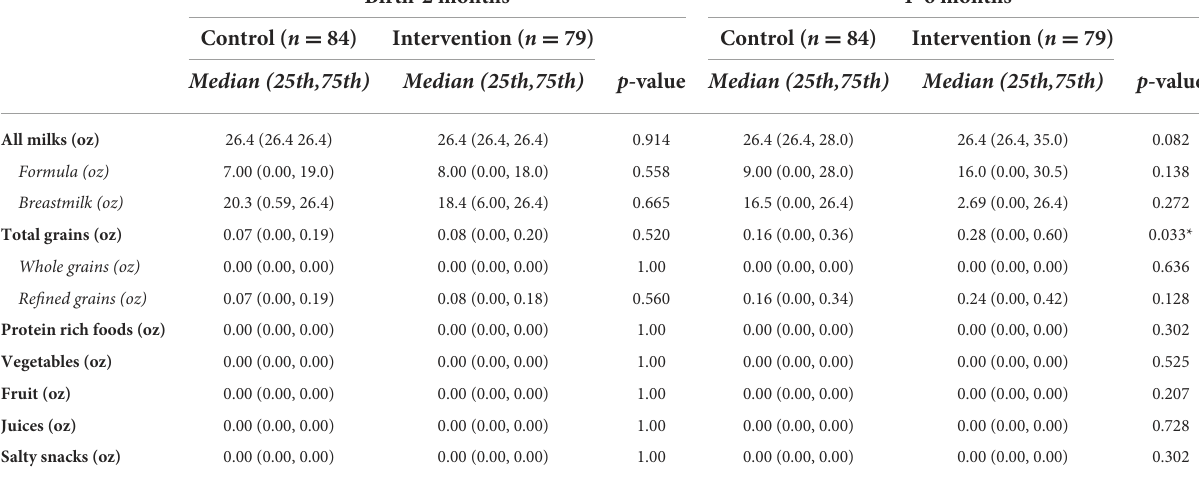
TABLE 3 Food groups intake at baseline (0–2 months) and at the follow-up visit (4–6